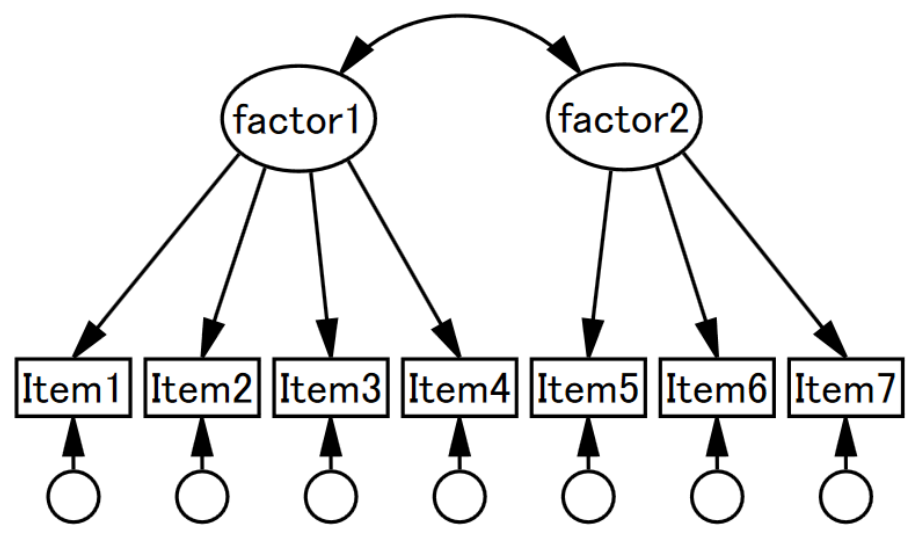
Figure 2. Two-factor model of the ISI for pregnant women ( n = 198). Then, we examined the measurement and structure invariance between nulliparas and multiparas and times 1 and 2. The two-factor model for the ISI was invariant with configural, metric, scalar, factor variance, and factor covariance perspectives for both parity and time points (Table 3). The factor means for both the severity and impact were not significantly different across parity and time points (Table 4). Table 3. Measurement and structural invariance.